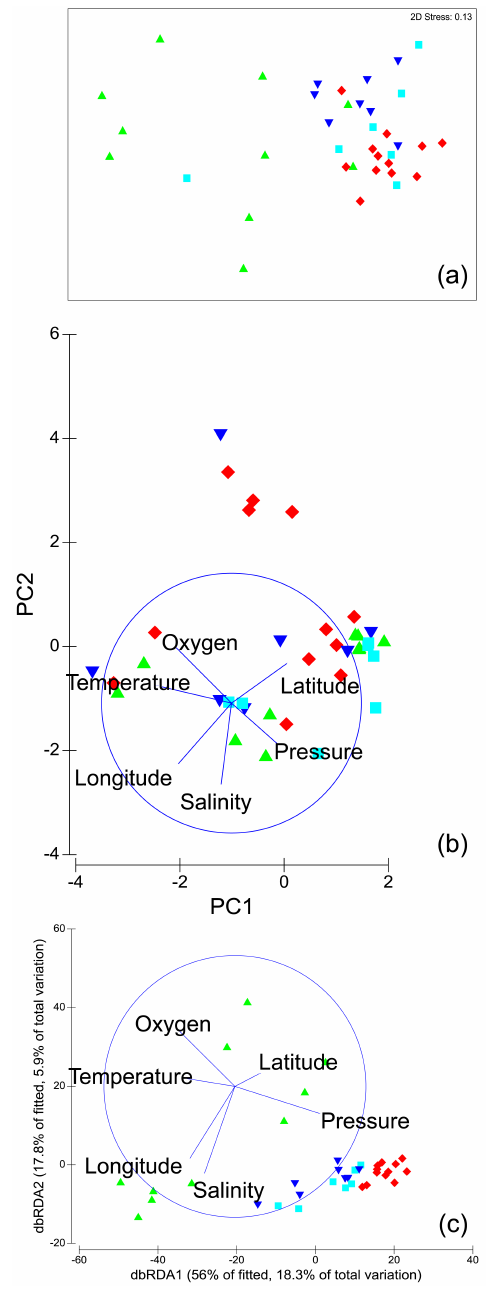
Fig. 5. Distribution of the bacterial communities throughout the wa- ter column according to biotic and environmental data. (a) Non- metric multidimensional scaling (NMDS) results based on quali- tative ARISA fingerprinting of the samples across the water col- umn, showing the distribution of epipelagic (green triangles), up- per mesopelagic (blue triangles), lower mesopelagic (light blue squares) and bathypelagic (red diamonds) samples. (b) Principal component analysis performed on the environmental data reported in Table S1 (Supplement). (c) dbRDA ordinations of the pres- ence/absence of the ARISA dataset overlaid with the partial cor- relations of the tested environmental